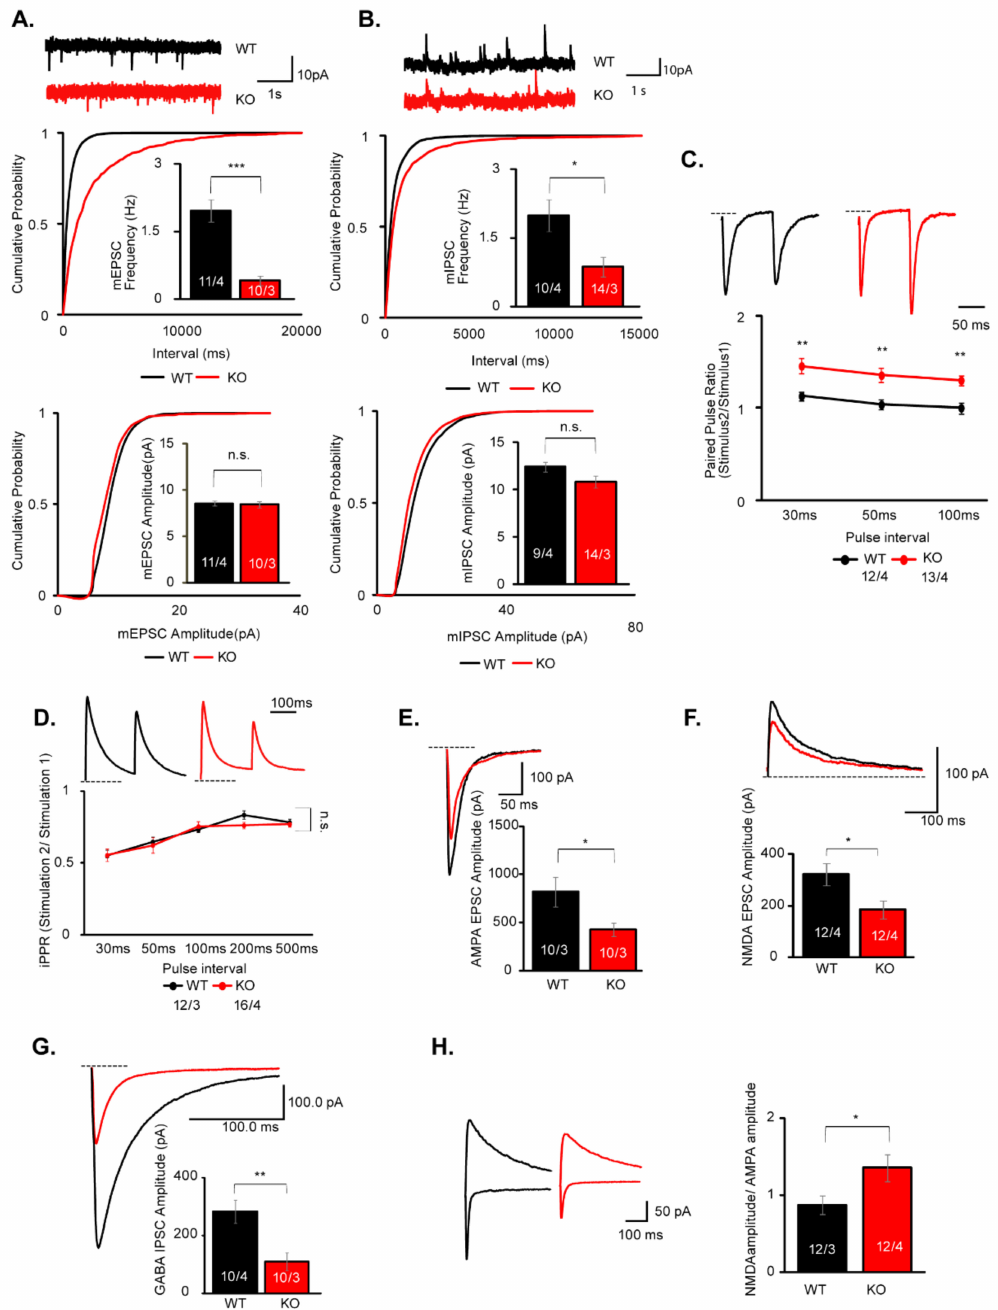
Figure 3. AMPAR, NMDAR, and GABAR-mediated synaptic transmissions are decreased in pyramidal neurons in layer 5 of the mPFC in P14-P19 IQSEC2 KO mice. ( A ) Sample traces and summary graphs for mEPSCs in pyramidal neurons in layer 5 of the mPFC in wild-type (WT) and IQSEC2 KO (KO) mice. The frequency, but not amplitude, of mEPSCs is decreased in IQSEC2 KO mice. ( B ) Sample traces and summary graphs for mIPSCs in pyramidal neurons in layer 5 of the mPFC in wild-type (WT) and IQSEC2 KO (KO) mice. The frequency, but not amplitude, of mIPSCs is decreased in IQSC2 KO mice. ( C ) Sample traces and summary graph for the paired-pulse ratio of evoked EPSC in wild-type (WT) and IQSEC2 KO (KO) mice. The paired-pulse ratio is increased in IQSEC2 KO mice in 30, 50, and 100 ms stimulation intervals, suggesting that the release probability is decreased in the IQSEC2 KO neurons. ( D ) Sample traces and summary graph for the paired-pulse ratio of evoked IPSC in wild-type (WT) and IQSEC2 KO (KO) mice. The paired-pulse ratio is unchanged in IQSEC2 KO mice. ( E ) Sample traces and summary graph for evoked AMPA EPSC in wild-type (WT) and IQSEC2 KO (KO) mice. The amplitude of evoked AMPA EPSC is decreased in IQSEC2 KO mice. ( F ) Sample traces and summary graph for evoked NMDA EPSC in wild-type (WT) and IQSEC2 KO (KO) mice. The amplitude of evoked NMDA EPSC is decreased in IQSEC2 KO